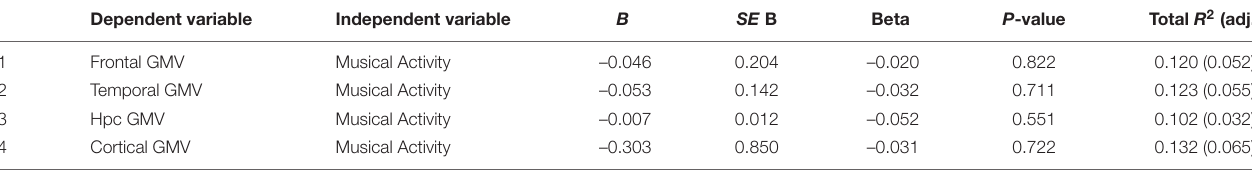
TABLE 3 | Results of linear regression analyses between musical activity and GMV in regions-of-interest.